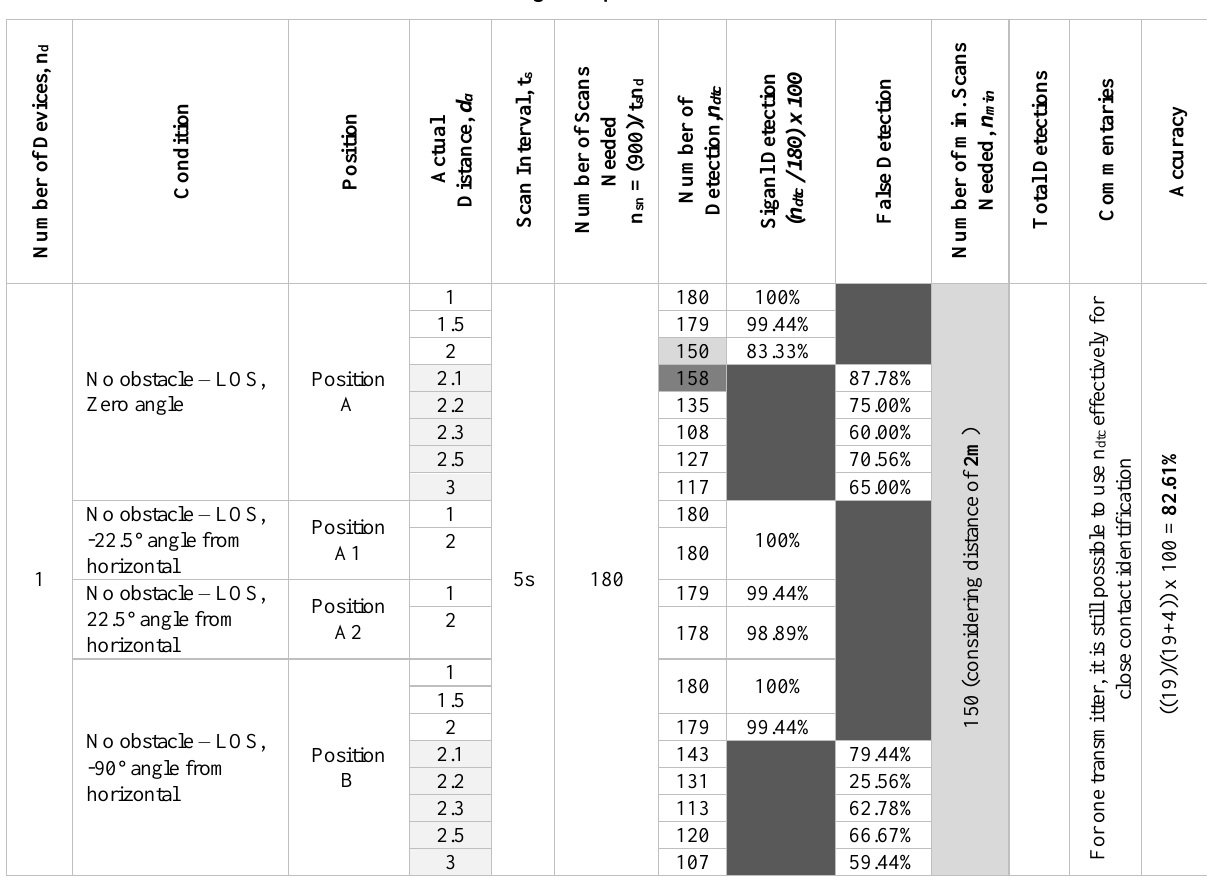
Table 4. Stage 2 Experimental